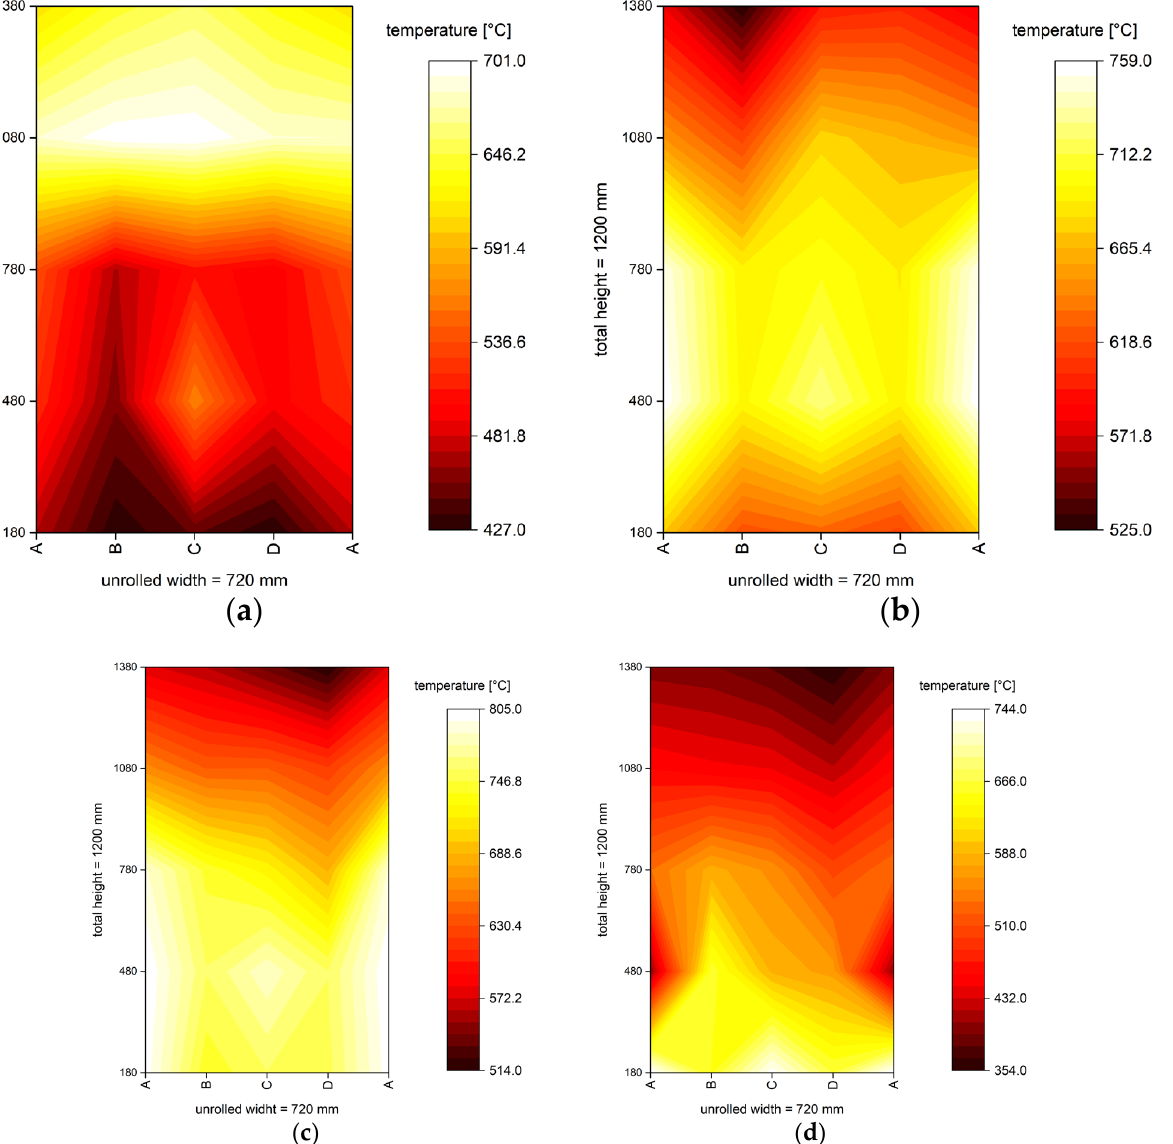
Figure 4. Temperature distribution on the unrolled cylinder shell: ( a ) 5 min; ( b ) 10 min; ( c ) 15 min; ( d ) 20 min.